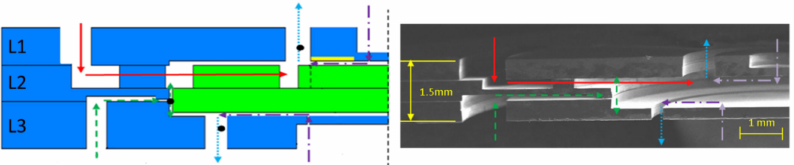
Figure 14. Cross-sectional view of designed MAB structure and manufactured MAB